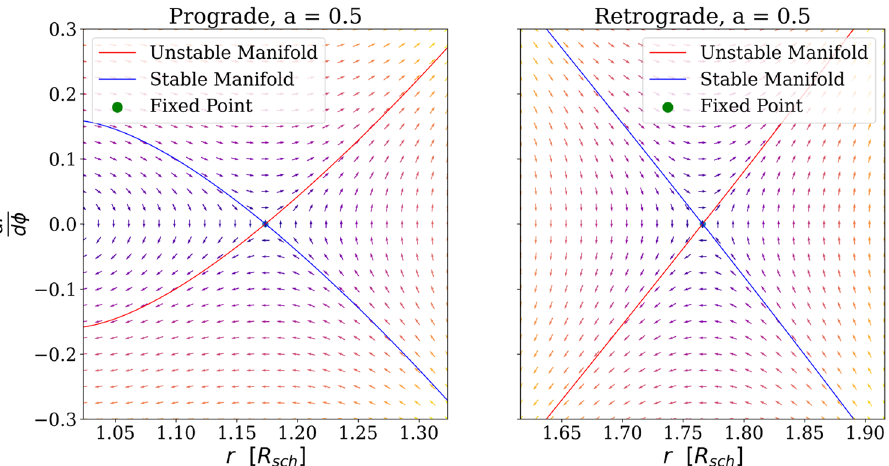
0.5 (left: prograde and right: = 1 r does not remove the =